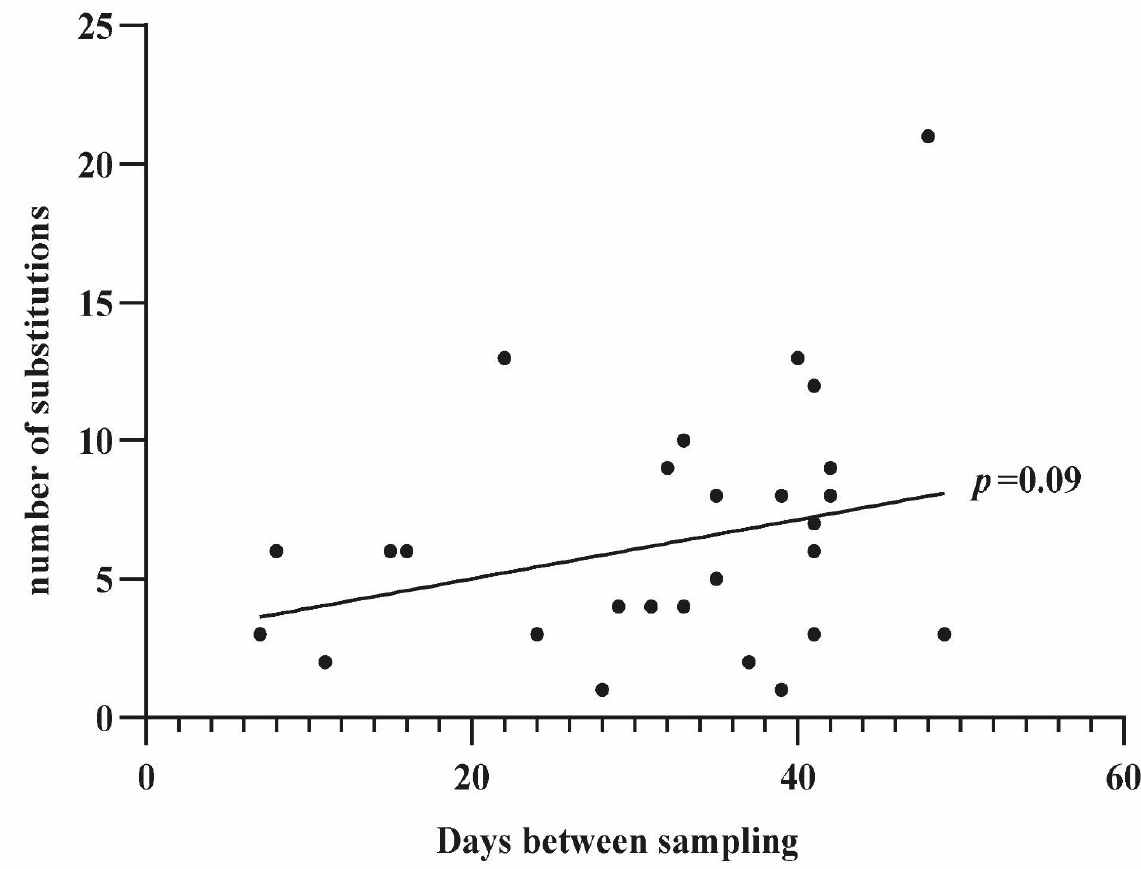
Figure 2. Number of SNPs in correlation to time between urine samples of the same patient. Line is linear regression line, tested for slope significance.